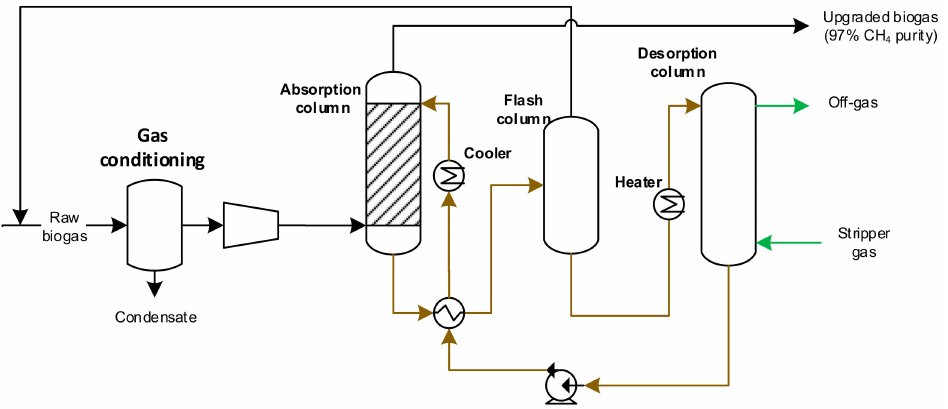
Figure 6. Biogas upgrading with organic solvents. Adapted from Muñoz et al.